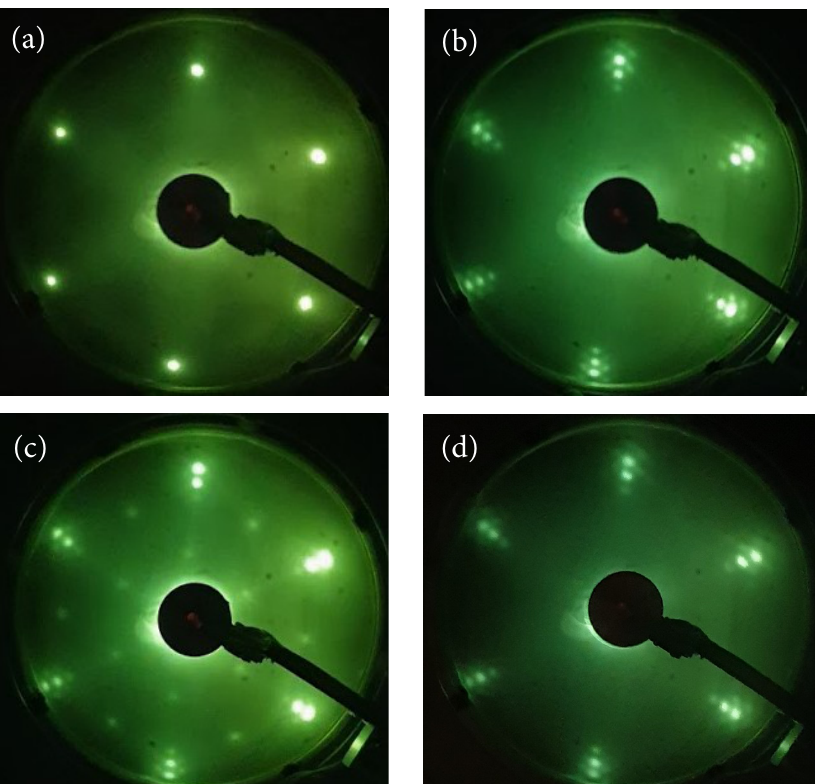
Figure 1. LEED images from: ( a ) Ru(0001); ( b ) Graphene/Ru(0001); ( c ) oxidized graphene/Ru(0001); and ( d ) oxidized sample annealed to 1000 K. An electron beam energy of 64 eV was